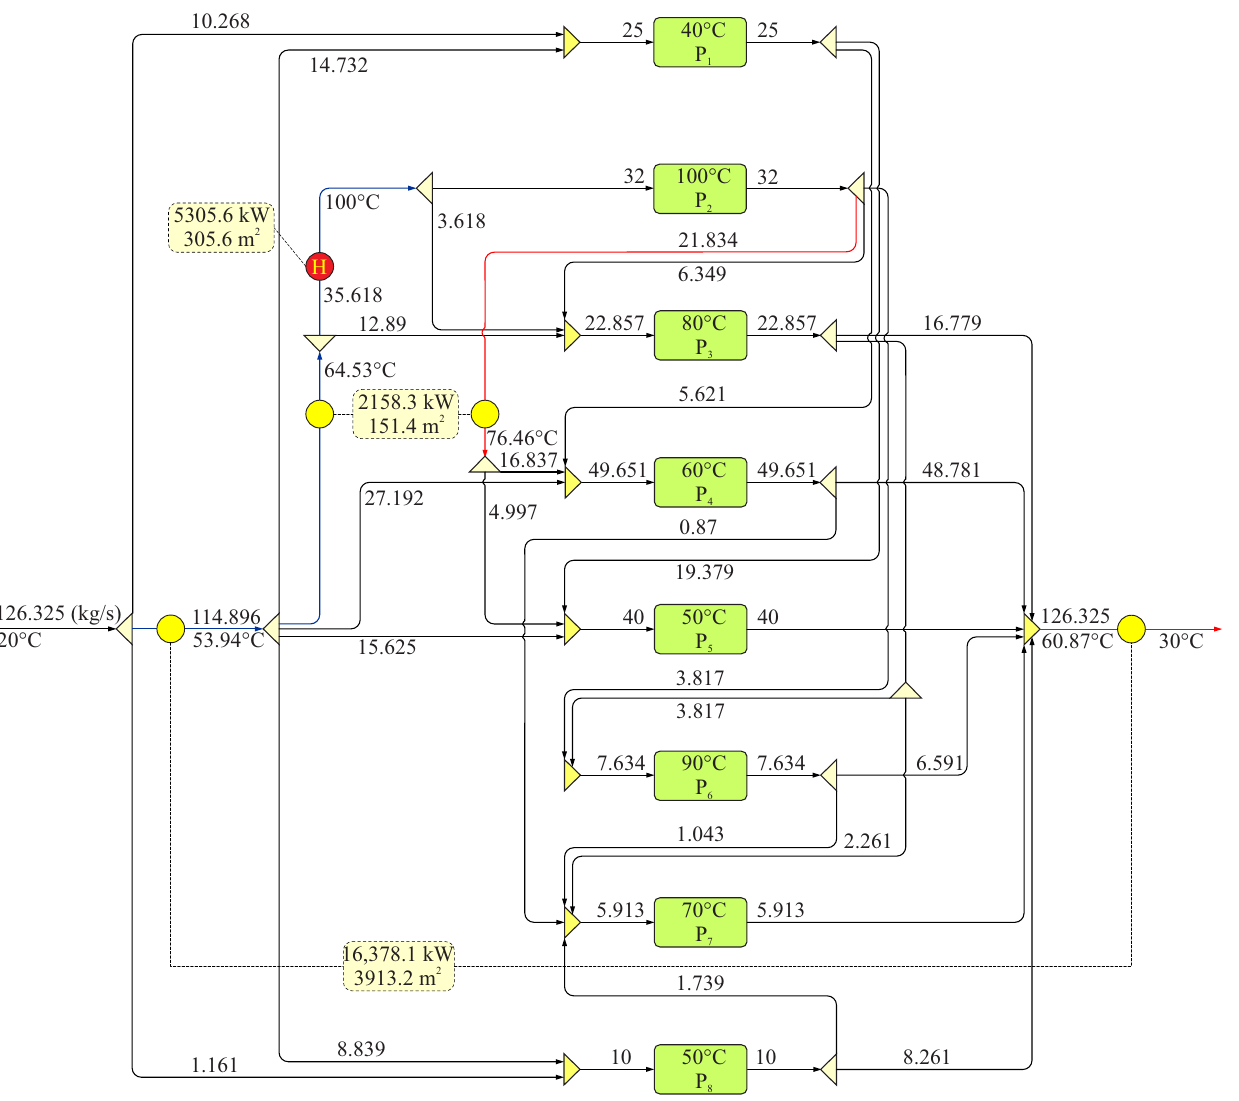
Figure 13. Optimal network design for Example 4. Table 9. Process water-using units data for Example